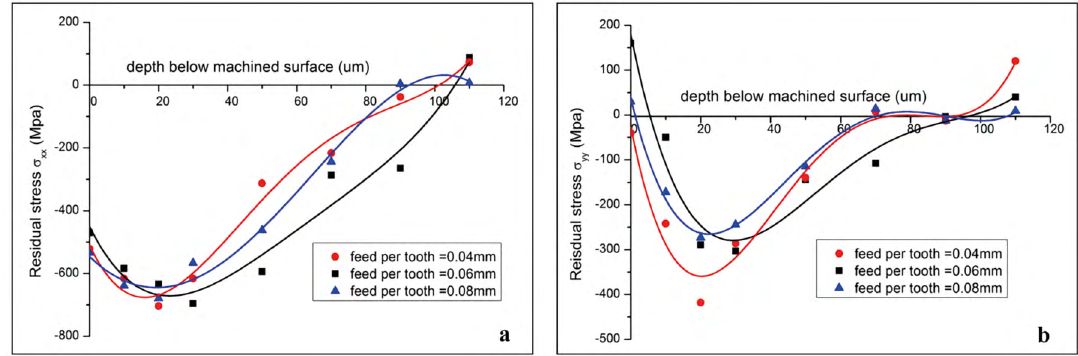
, (b) σ , ( a =0.3mm, a =0.2mm, V =60m/min, lead angle=10°, tilt angle=0°, xx yy p e eff